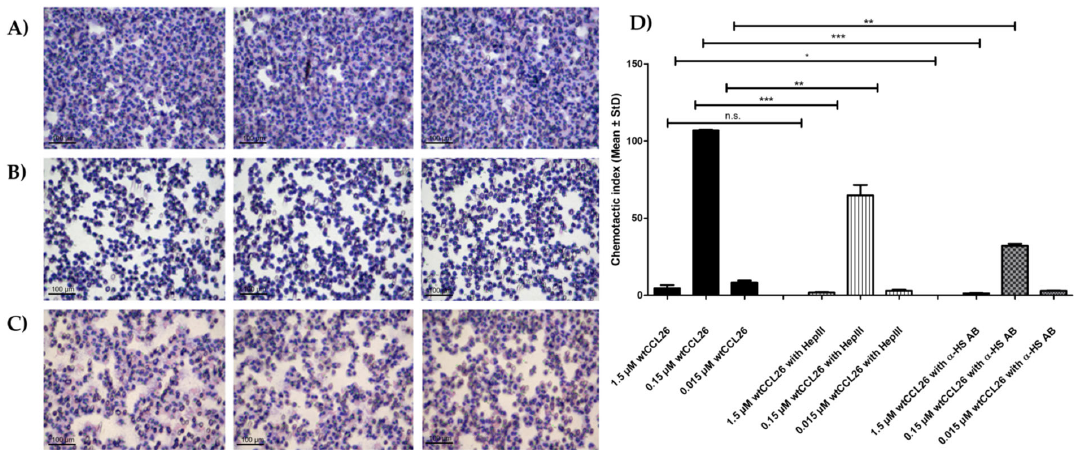
Figure 8. Left , migrated eosinophils for ( A ) untreated, ( B ) heparinase ‐ III ‐ treated, ( C ) anti ‐ HS ‐ antibody masked eosinophils in response to 150 nM CCL26 visualized via 40x magnification. Right , ( D )